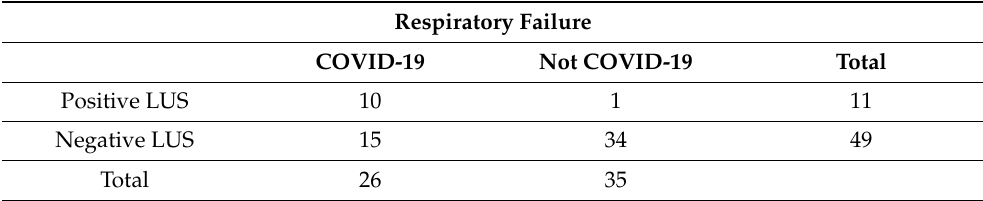
Table 9. 2 × 2 contingency table for LUS, considered positive in presence of A pattern or pleural effusion with A pattern or B-lines that do not represent diffuse